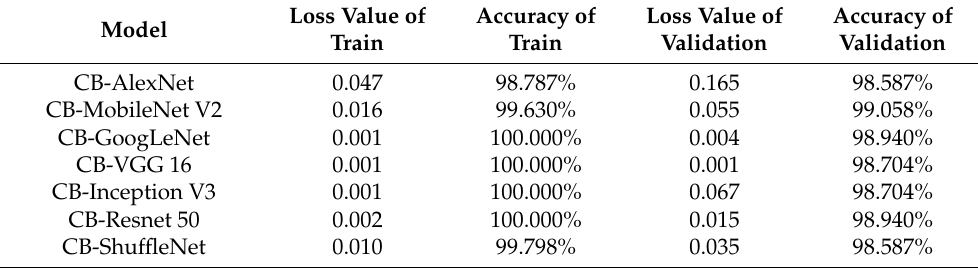
Table 5. Optimal results using different